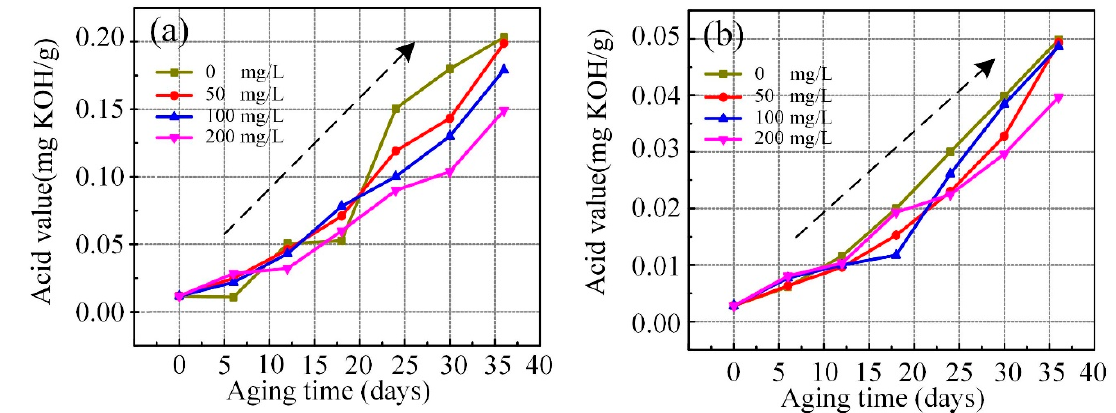
Figure 8. The variation of acid with C 60 concentration of aging vegetable insulating liquid ( a ) and aging mineral liquid ( b ).